Question: Write the caption for this figure.
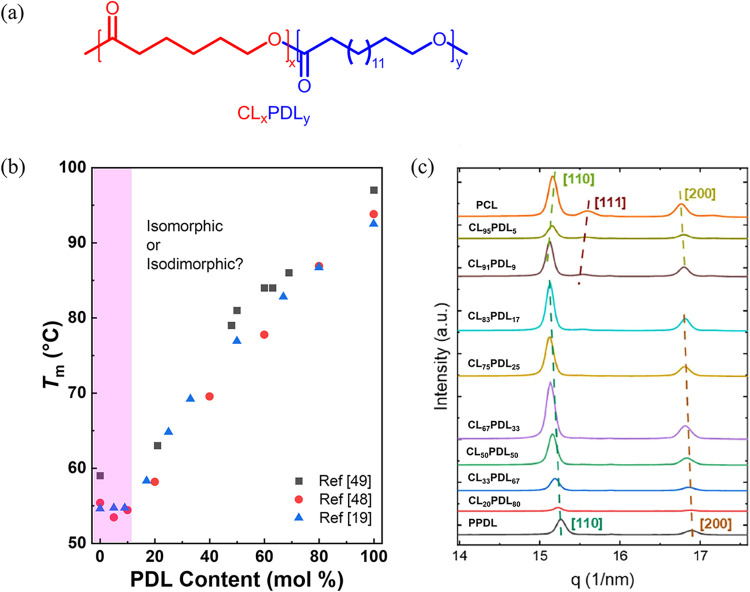
Answer: (a) PDL x CL y chemical structure, (b) comparison of T m vs PDL content of works reported in the literature, , , and (c) WAXS patterns. The shaded region in (b) highlights the compositional interval in which the asymmetric pseudoeutectic behavior, and thus the isodimorphic character of the system, becomes evident. Figure 7 highlights how insufficient compositional sampling may conceal pseudoeutectic behavior and lead to overestimation of strict isomorphic crystallization. Figure 7 is adapted from refs , , and . Copyright 2015, 2005, and 2025 American Chemical Society.